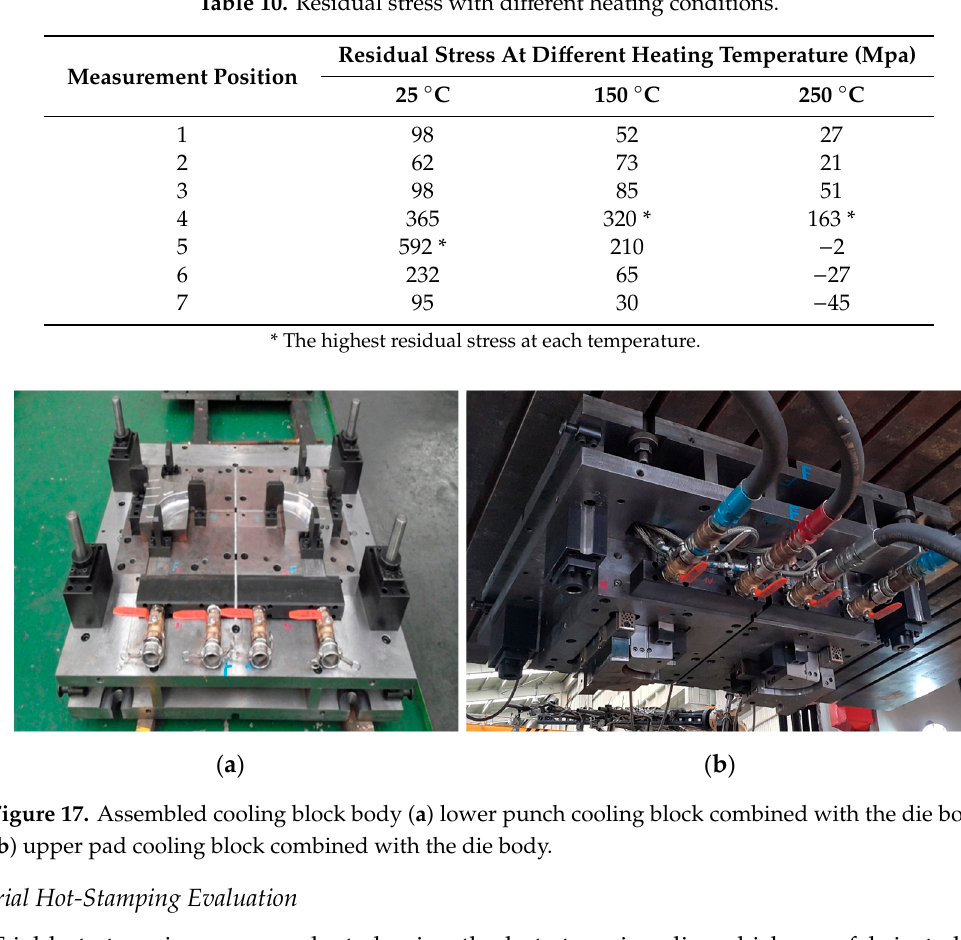
15 of 20 Figure 16. Schematic of AM process and measurement positions of residual stress. Table 10. Residual stress with different heating conditions. Measurement Position